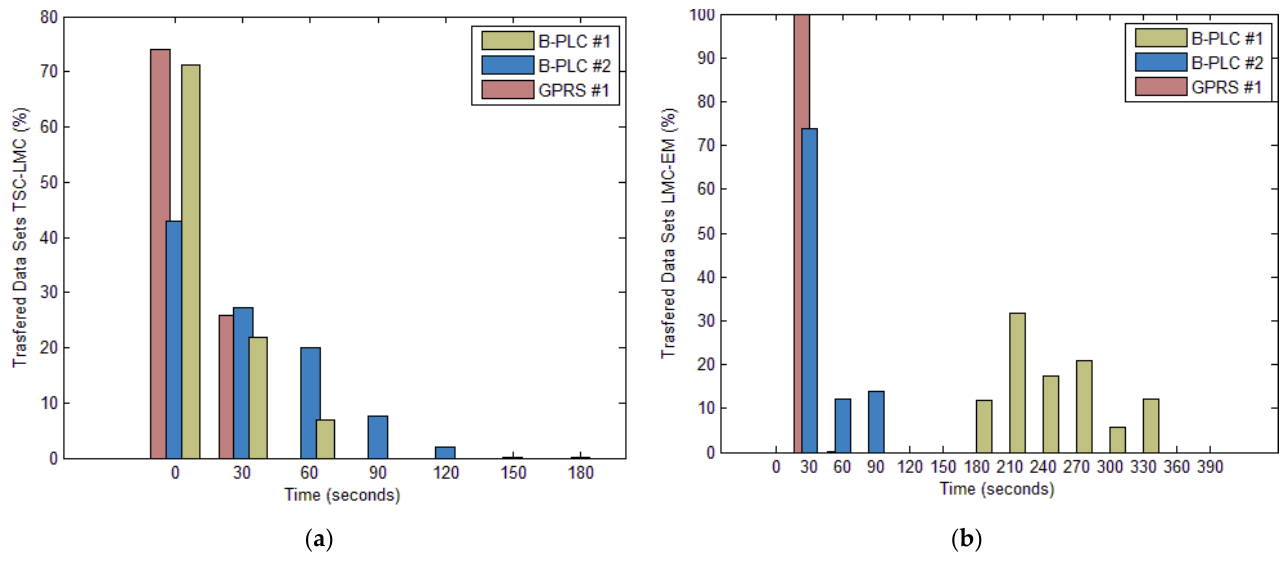
Figure 7. TCS area-specific distribution of the inter-node data availability time of load profile data along: ( a ) TSC-LMC data path; ( b ) LMC-EM data path.